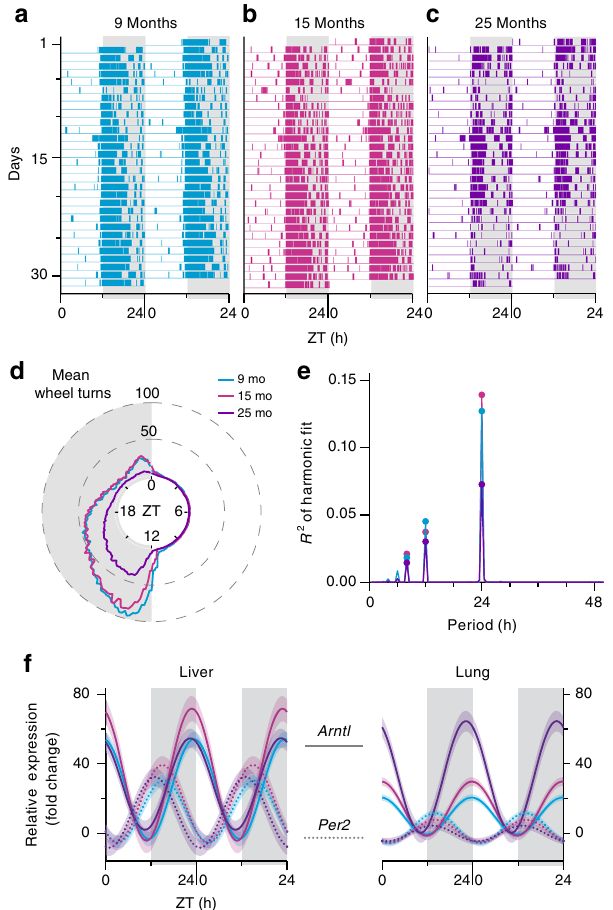
Fig. 2 Locomotor activity and molecular markers verifying circadian entrainment of mice. a - c Representative actograms of individual mice from a 9-mo, b 15-mo, and c 25-mo cohorts. The colored bars represent wheel running activity over 30 days. The light and grey columns show periods of lights on and off. By convention, each line depicts 2 days of activity, with the second day appearing again in the line below (i.e., double-plotted). d The summarized activity of each age cohort measured as the mean number of turns for each mouse in the age group (measured in 6 min intervals over 30 days) as a function of ZT. e Spectral analysis of the actograms in each age cohort showing the R 2 of harmonic fi ts at varying periodicities (1 h intervals). f Twenty-four hours harmonic regression fi ts of relative mRNA levels of two antiphasic circadian genes, Arntl and Per2 , in liver and lung tissues of all three age cohorts. The data are double plotted by convention. Shading around the regression lines represents the 95% con fi dence